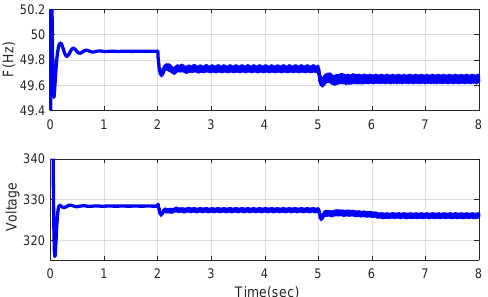
Figure 8. Instantaneous voltages at the DG terminals during unbalanced load changes in feeder F 1 , ( a ) DG 1 and ( b ) DG 2 .